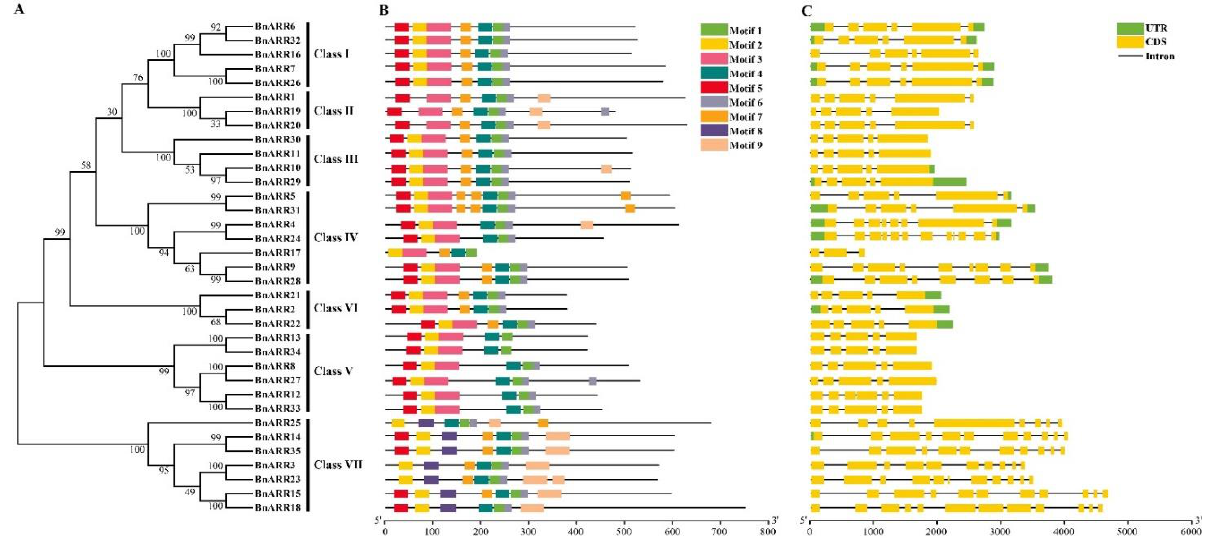
Figure 3. Gene structure and motif composition of type-B ARRs in B. napus . ( A ) Phylogenetic tree of BnARRs. ( B ) Conserved motifs in BnARRs. Motifs 1~10 are displayed with different colored boxes. The detailed motif structure is showed in Figure S1. ( C ) Gene structure of BnARRs . UTR, untranslated region; CDS, coding sequence.